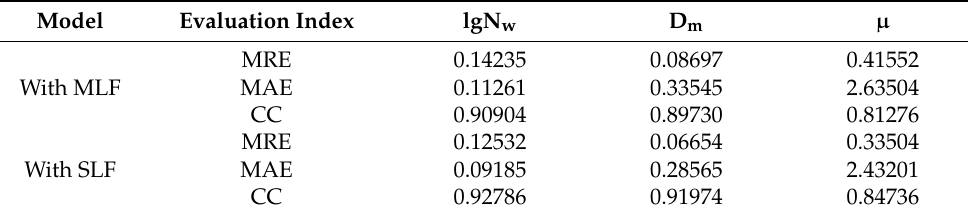
Table 7. The 30-min prediction evaluation results of mixed convective-stratiform clouds.